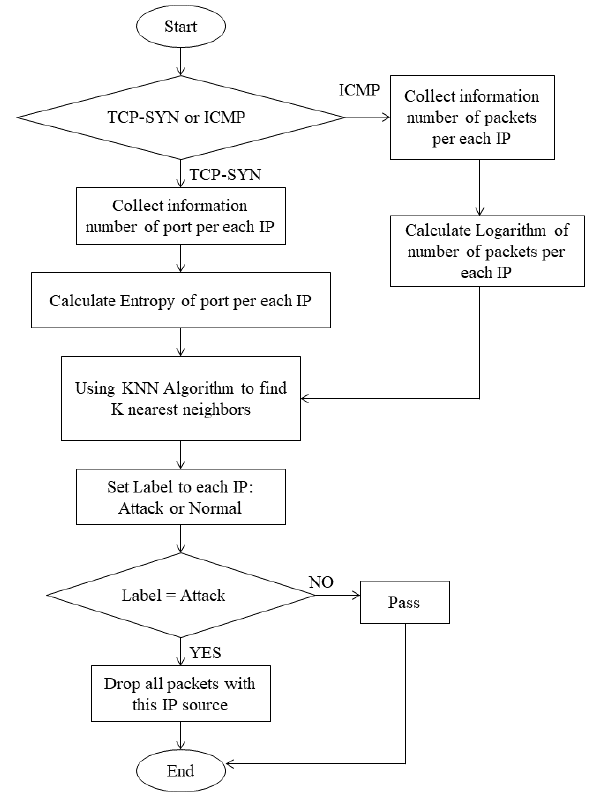
Figure 5. Mitigation process